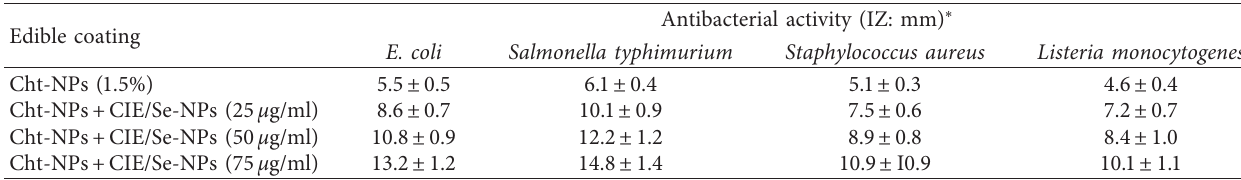
Table 3: Antimicrobial capacities of formulated edible coating from chitosan nanoparticles (Cht-NPs) and phycosynthesized Se nano- particles with cinnamon extract (CIE/Se-NPs) against food-borne bacteria. Edible coating